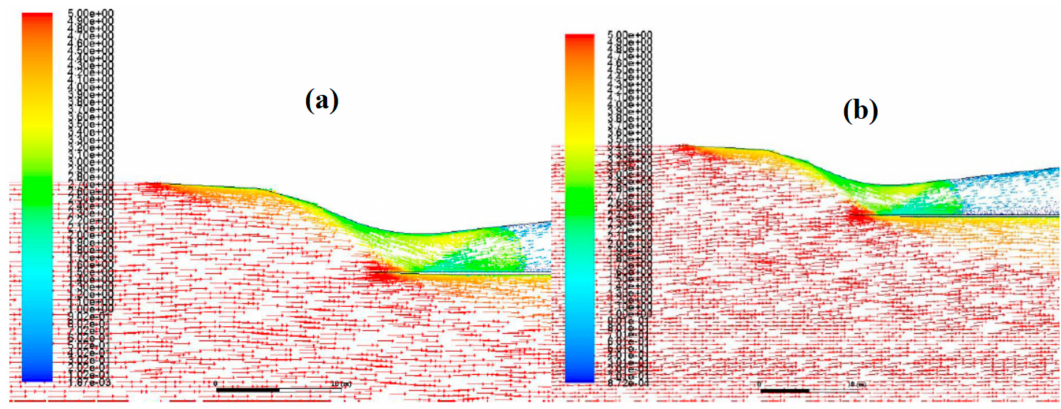
Figure 11. ( a ) Mach 5, AoA of 0 ◦ and ( b ) Mach 5, AoA of 3 ◦